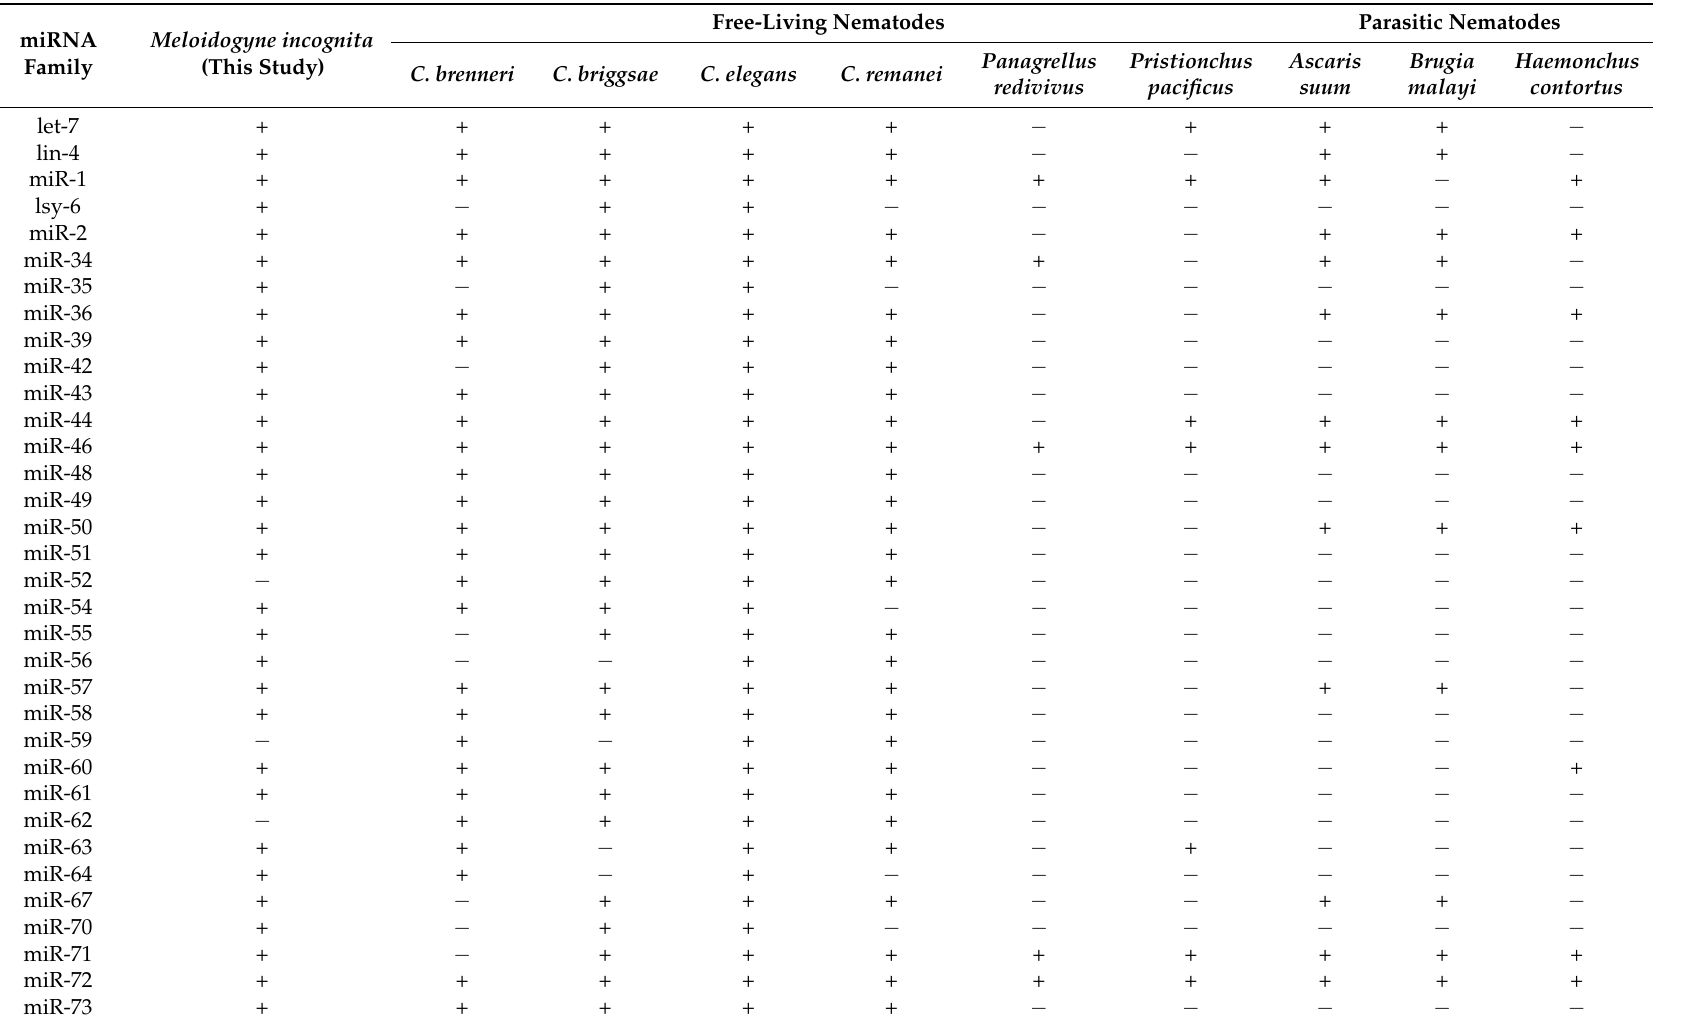
Table 6. Comparison of conserved miRNA families among other nematode